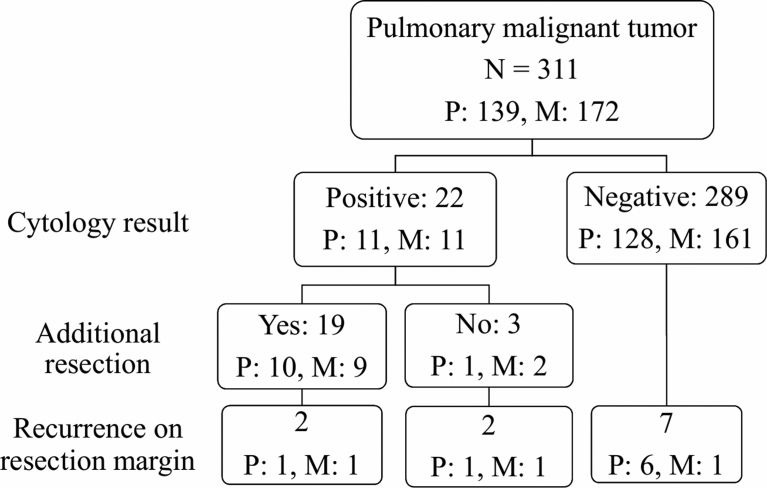
Surgical conversion and clinical course. P, primary lung cancer; M, pulmonary metastatic tumor.